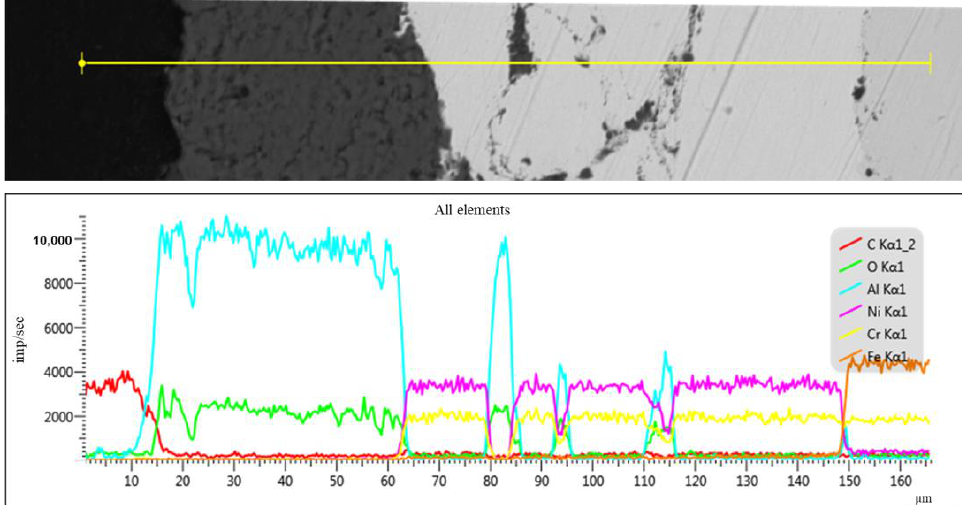
Figure 9. Distribution of elements along the cross-sectional line of the five-layer gradient coating.